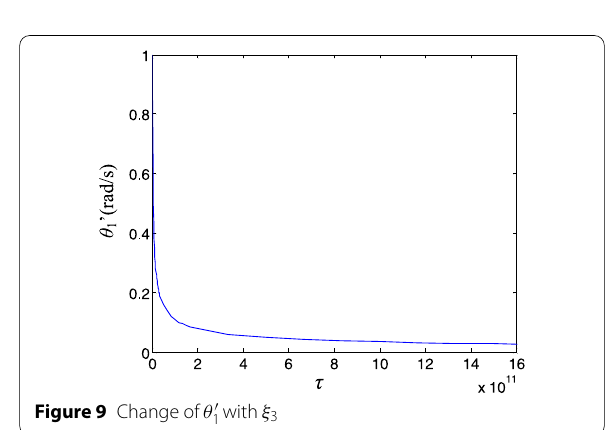
Figure 9 Change of θ ′ 1 with ξ